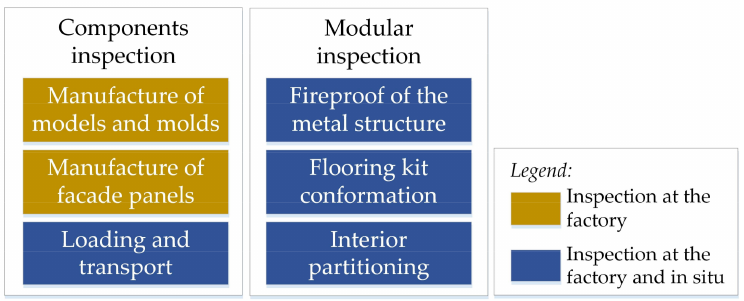
Figure 1. Inspection of components and modules of pre-fab